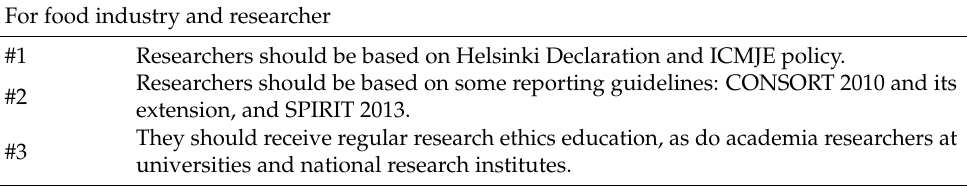
Table 3. Future challenges to improve protocol compliance in the food-related clinical trials. For food industry and